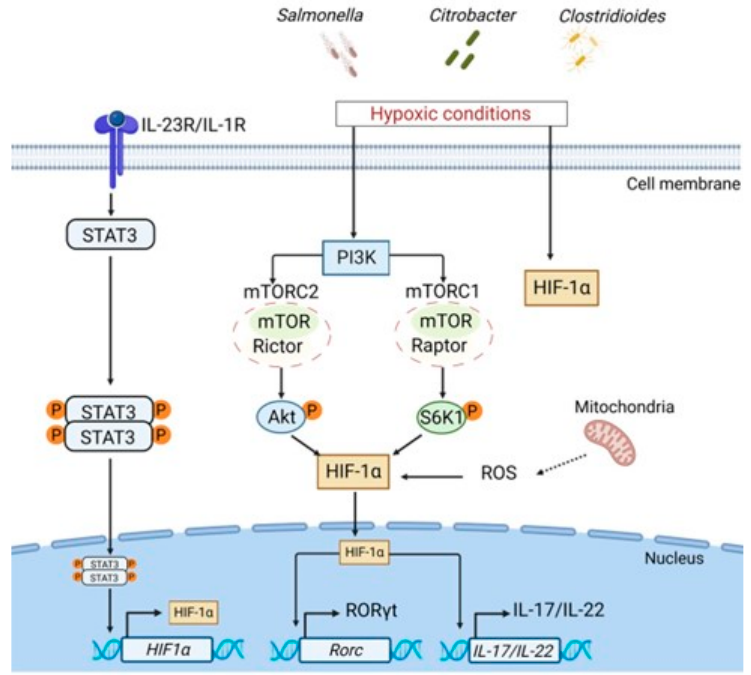
Figure 3. Role of hypoxia in regulation of ILC3 responses. Bacterial infections, such as Salmonella , Citrobacter or Clostridioides promote intestinal hypoxia. Under homeostatic conditions HIF-1 α is expressed at low levels. During hypoxia, HIF-1 α is activated and stabilized via STAT3, PI3K-mTOR signaling pathways and reactive oxygen species (ROS) produced in mitochondria. HIF-1 α translocates to the nucleus and induces transcription of ROR γ t and IL-17/IL-22 cytokines to protect against bacterial pathogens.